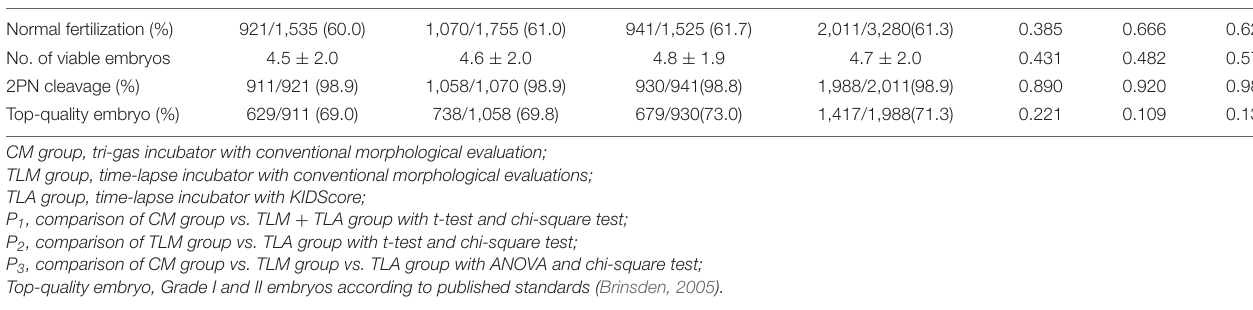
TABLE 2 | Embryo development rates for the as-treated patients in three groups. Variable